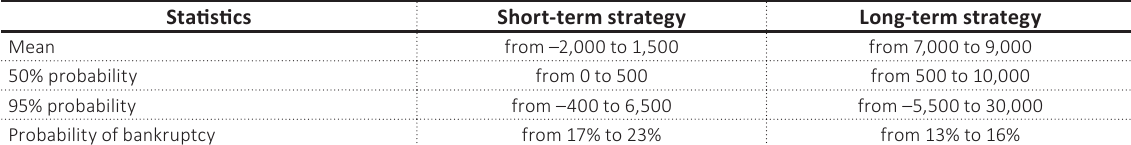
Table 1. Monte Carlo simulation results for short-term and long-term cryptocurrency investment strategies (the profit/loss per one Bitcoin in dollars